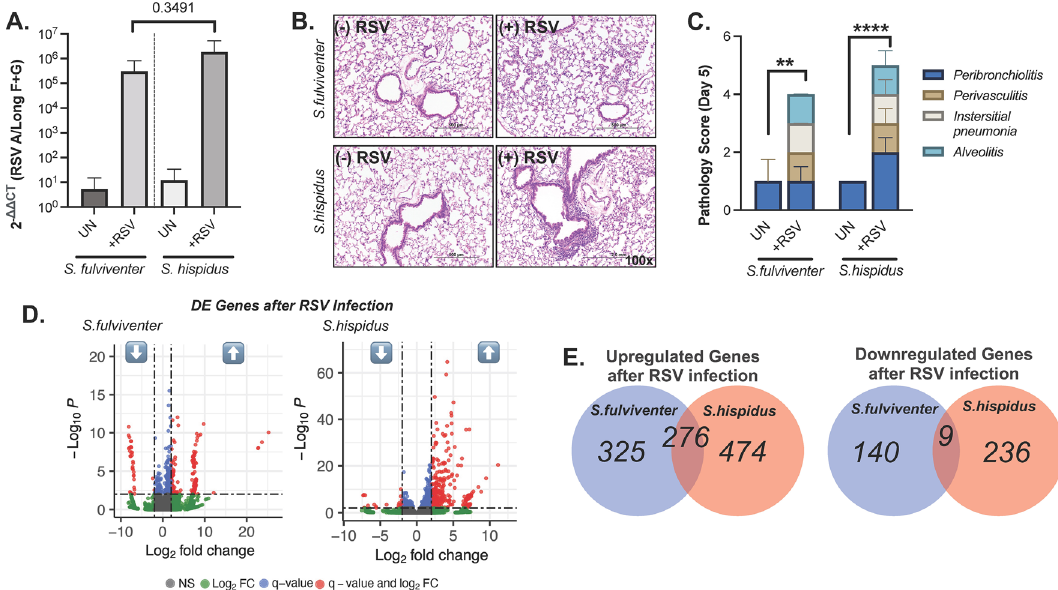
Figure 4. RSV-induced changes to the lung environment. ( A ) Viral titers (RSV G and F proteins) in uninfected and infected lungs determined by qRT-PCR normalized to β-actin; fold change (calculated by 2 −ΔΔCT ) on the y-axis. ( B ) Histopathological imaging and ( C ) blindly generated pathology scoring for both healthy (n = 4/ species) and RSV-infected (n = 5/species) lung tissue from S. fulviventer and S. hispidus . ( D , E ) DESeq2 analysis of assembled genes from lung tissues (same tissue imaged from Figures A-B) revealed several genes that are differentially expressed (DE) between healthy and infected tissues ( p < 0.05, q < 0.05, l2fc >|1.0|) of S. fulviventer (blue) and S. hispidus (red), of which several genes were successfully annotated using Trinotate (as indicated in boxes). * p ≤ 0.05, ** p ≤ 0.01, *** p ≤ 0.001, **** p ≤ 0.0001.